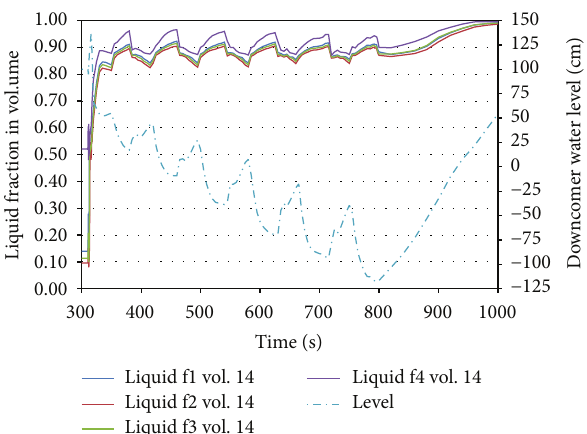
Figure 6: Water level drop in downcomer during the LOOP and recovery when starting the HPCS and RCIC, and liquid fraction in node at top of fuel.